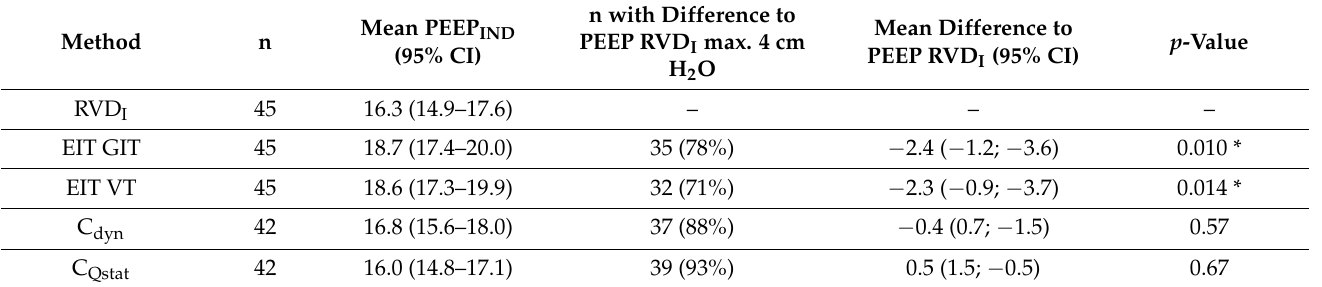
Table 2. Comparison of different methods for PEEP IND determination during a decremental PEEP trial compared to the regional ventilation delay index method (RVDI) using Electrical Impedance Tomography (EIT); data are shown as mean with 95% CI or number (percent). * p < 0.05